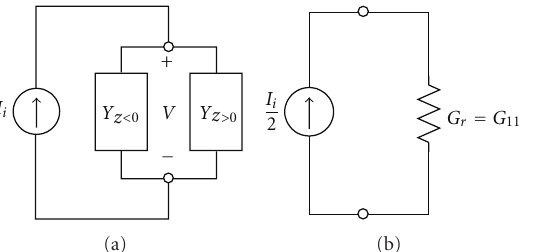
Figure 3: Equivalent circuit representation of single aperture for (a) general case and (b) its simplification from viewpoint of resonant transmission.